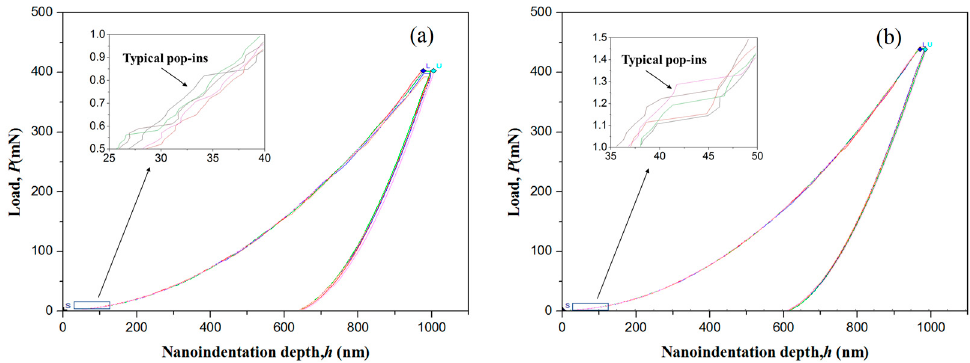
Figure 3. Typical load-displacement curves of sapphire crystal indented on the ( a ) A-plane and ( b ) C-plane under ultra-low nanoindentation loads at room temperature. Inset is the magnified region indicated by a rectangle, which presents the pop-in during loading.